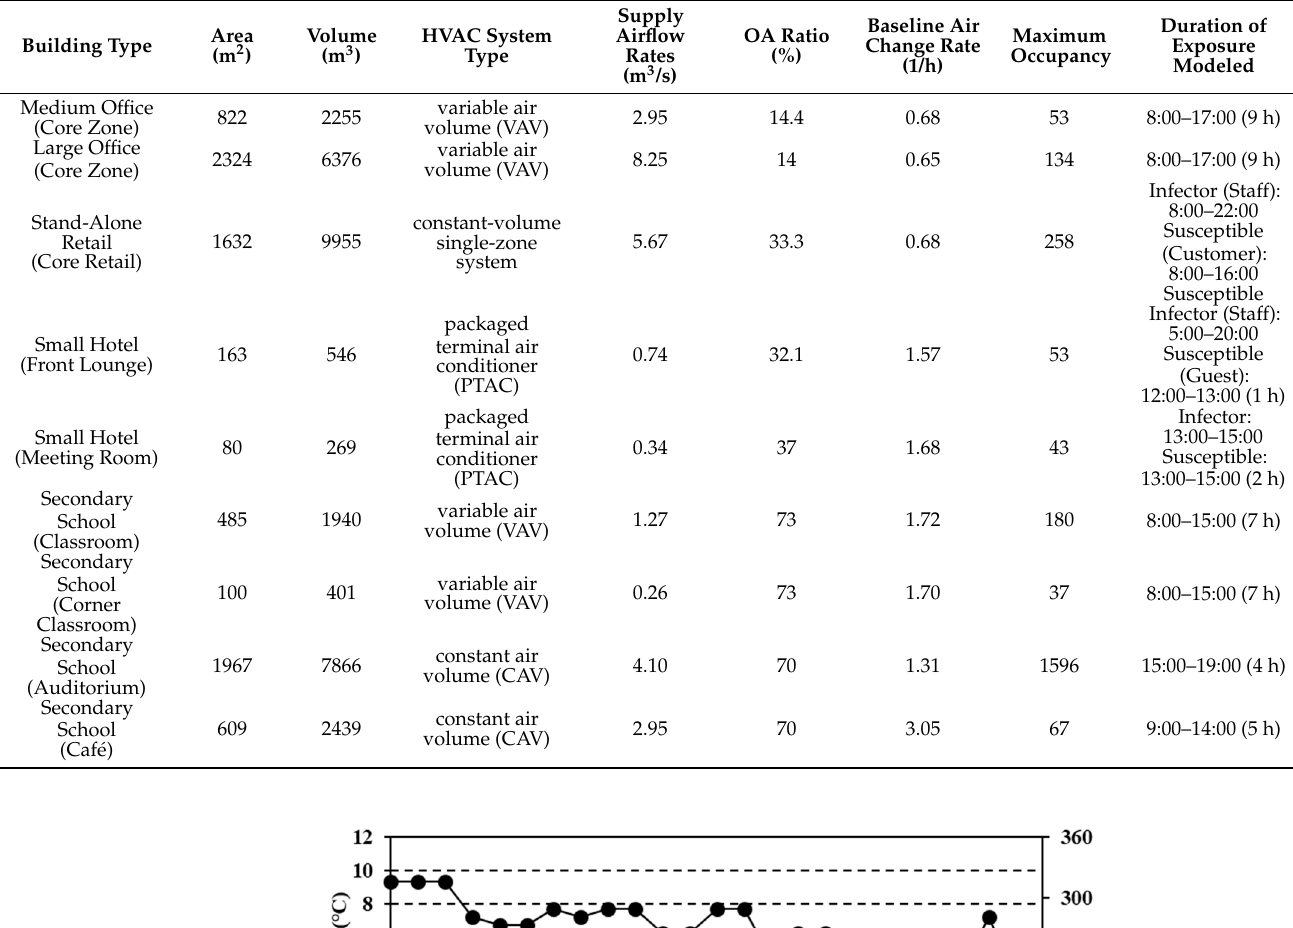
Table 1. Infectious Zone Characteristics for Simulated Prototype Buildings.